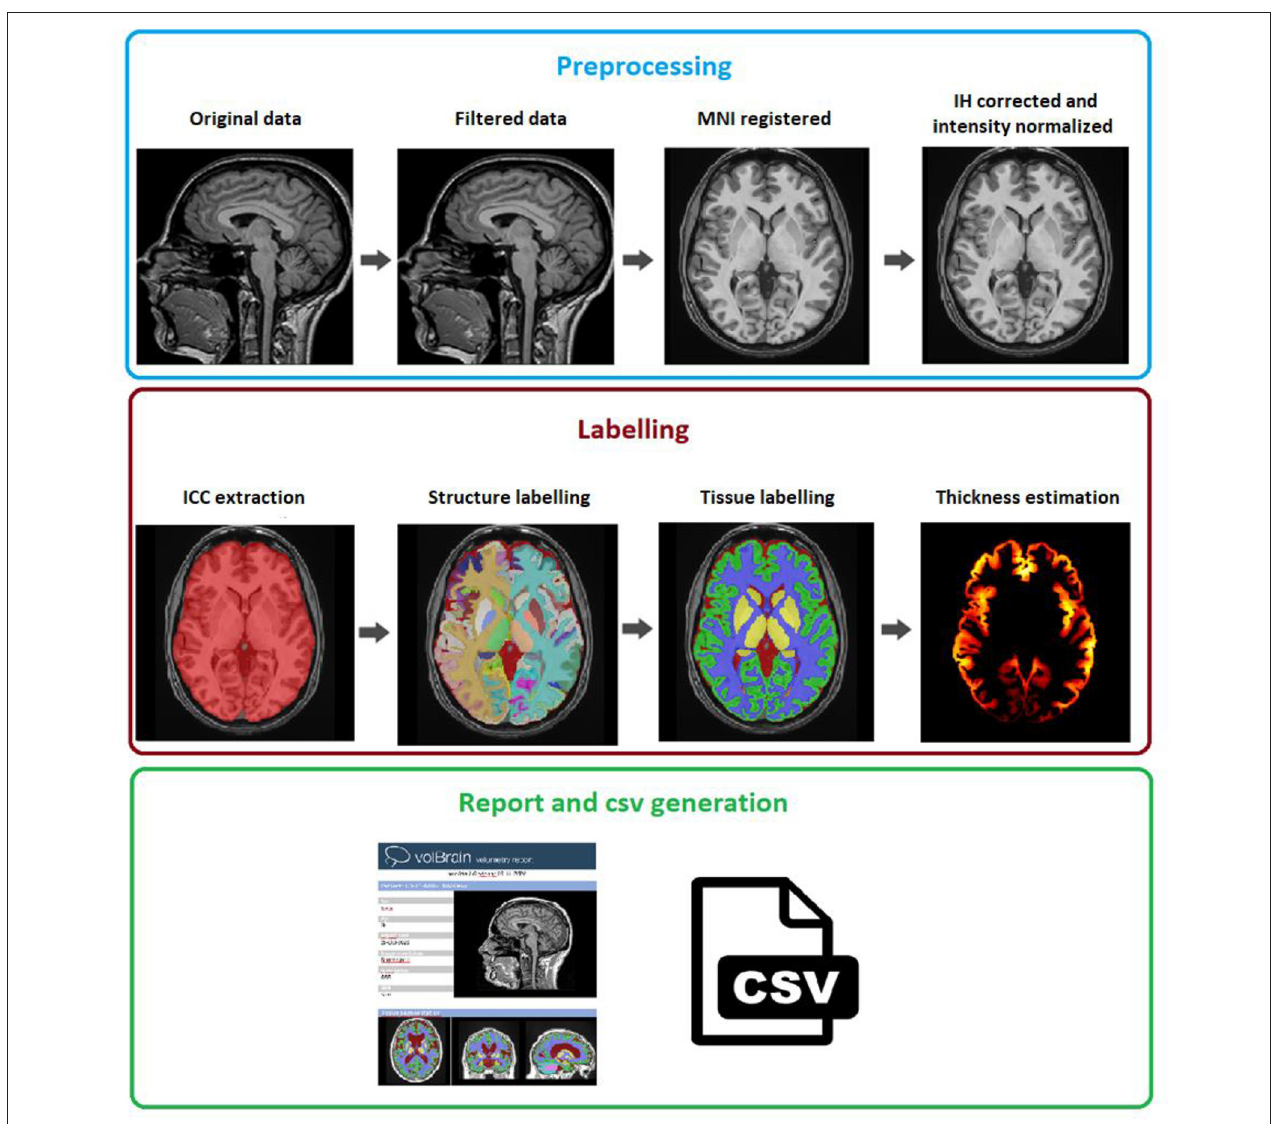
FIGURE 3 | vol2Brain pipeline scheme. In the first row, the preprocessing for any new subject is presented. In the second row, the results of the ICC extraction, structure, and tissue segmentations jointly with the cortical thickness estimation are presented. Finally, in the third row, the volumetric information is extracted and